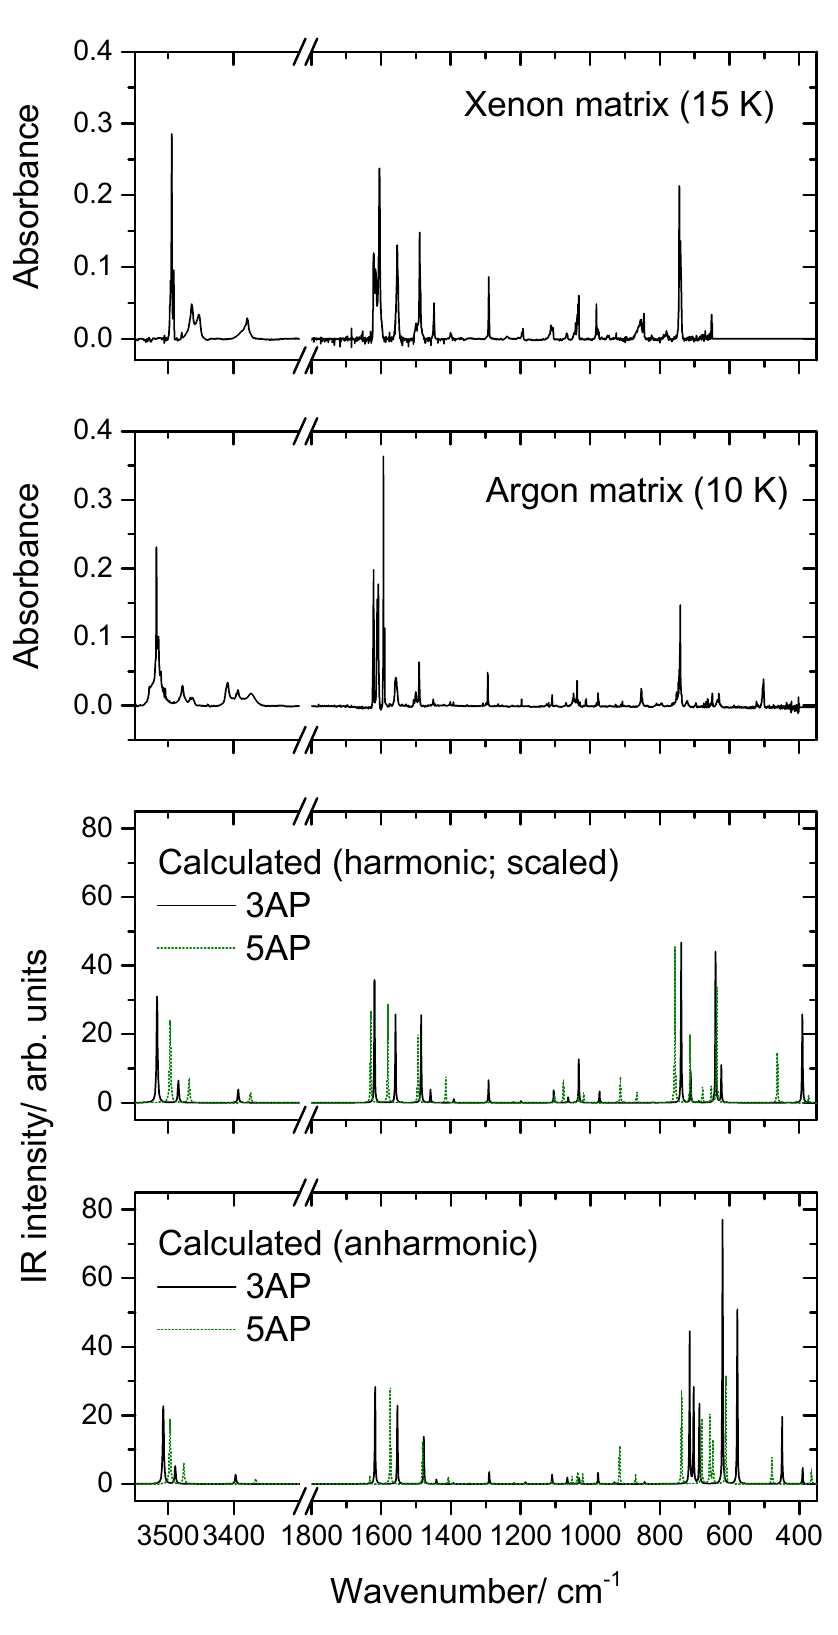
Figure 2. Experimental IR spectra of 3(5)-aminopyrazole isolated in Xe and Ar matrices and B3LYP/6-311++G(d,p) calculated harmonic (scaled) and anharmonic IR spectra for 3AP and 5AP tautomers. Bands due to trace H 2 O impurity were subtracted.